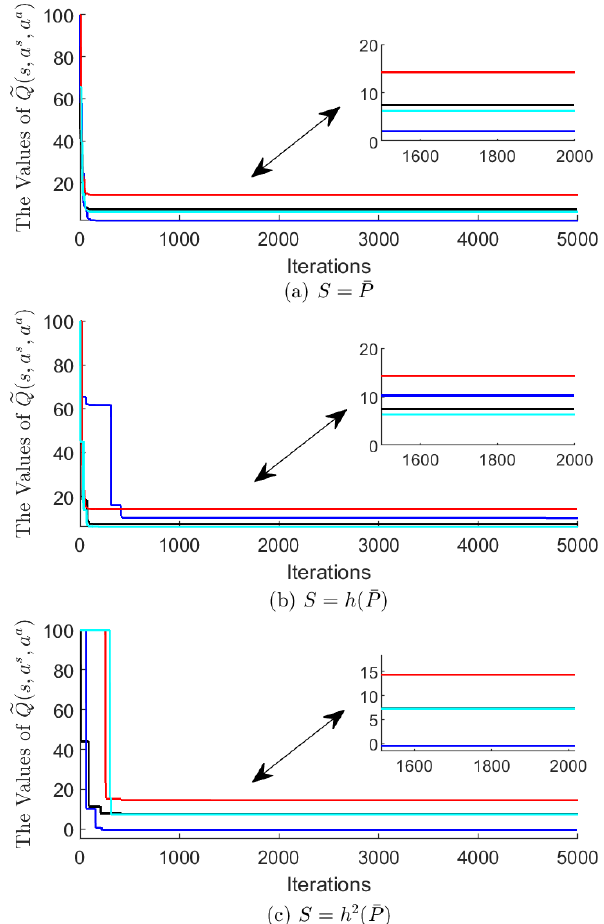
Figure 4. Learning process of Q ( s , a s , a a ) for reliable